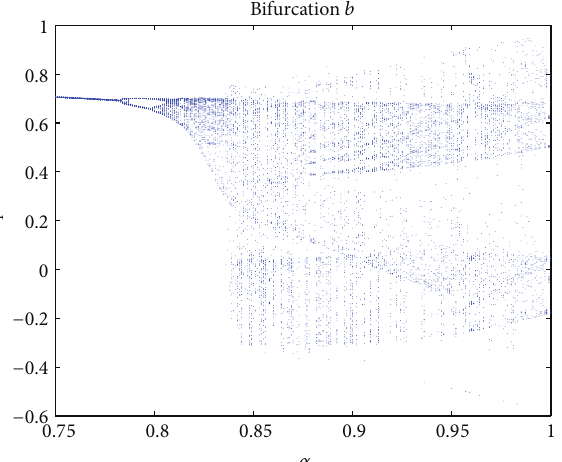
Figure 6: Bifurcation diagrams of 𝑥 1 with respect to the derivative order 𝛼 when 𝑏 22 = 3.0, 𝑐 22 = −2.5